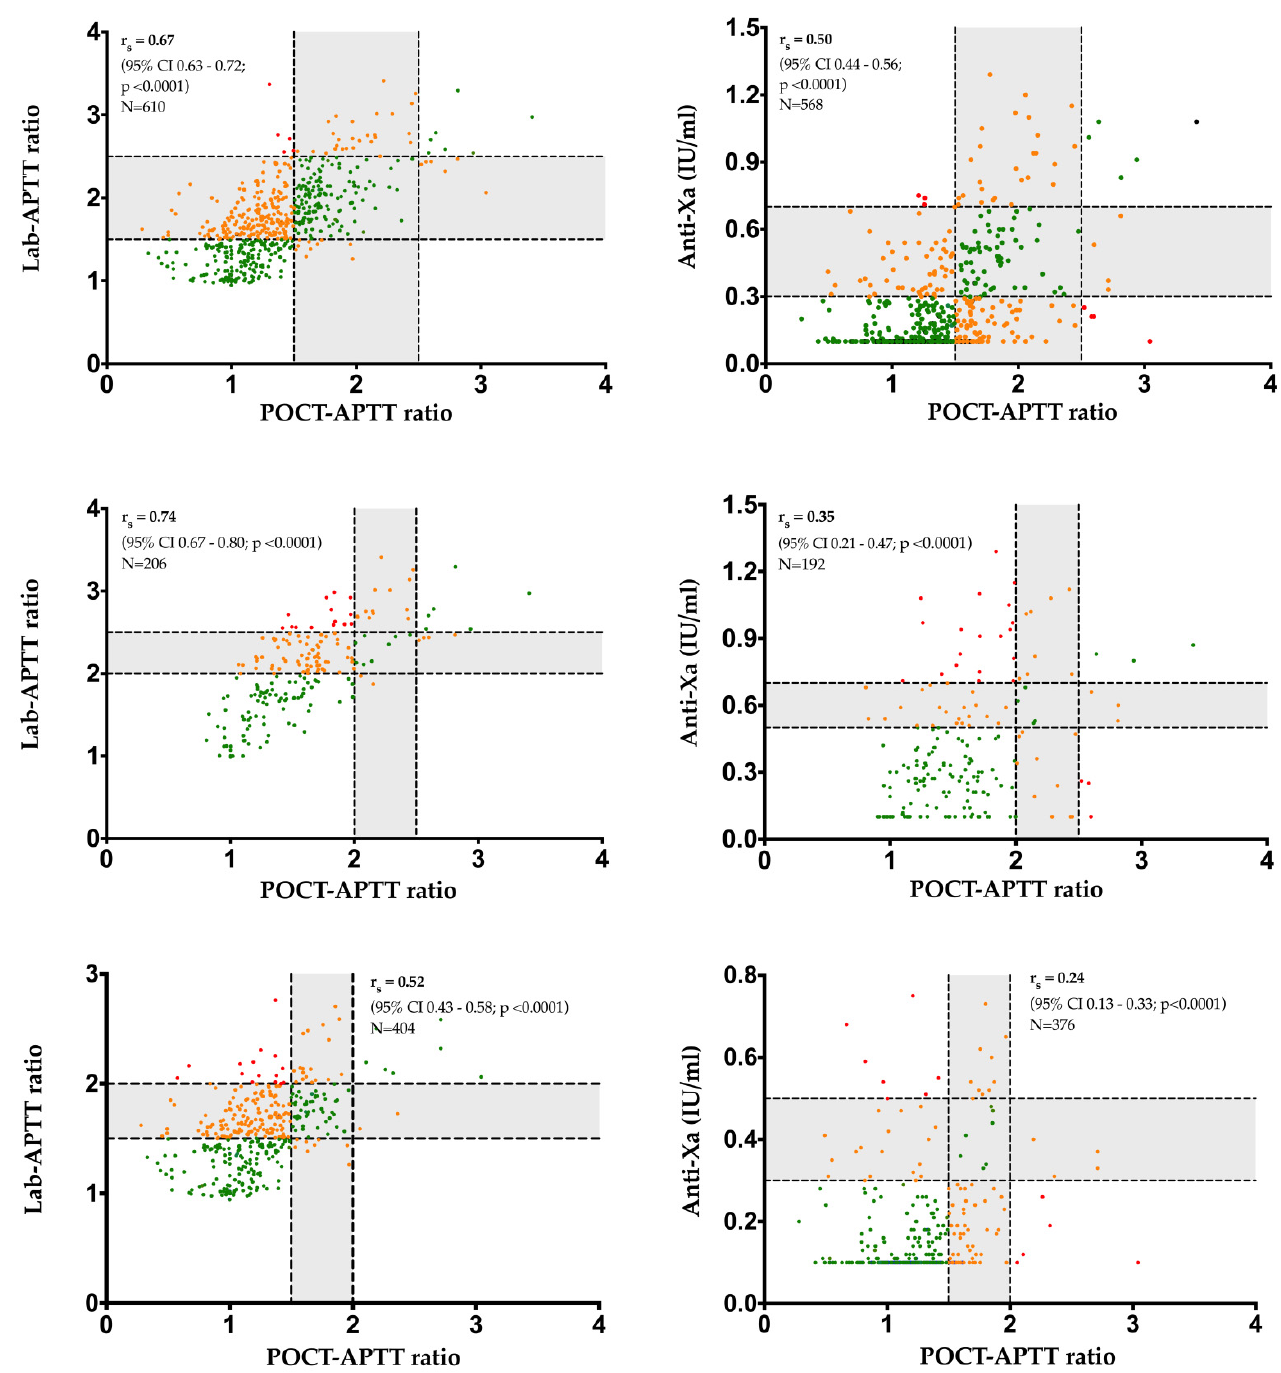
Figure 4. Correlations of the POCT-APTT ratios vs. laboratory APTT ratios (left panels) and POCT- APTT ratios vs. chromogenic anti-Xa activity measurement (right panels), according to overall (top panels), high (center panels) or low (bottom panels) therapeutic target ranges from the 29 patients with basal POCT and basal lab-APTT measurements. The grey zone corresponds to the desired therapeutic range and tick lines represent the lower and the upper limits of this range for the corresponding assay. Pairs in agreement, unsatisfactory and contradictory categories are symbolized by green, orange and red dots, respectively. APTT, activated partial thromboplastin time; POCT, point-of-care testing; rs, Spearman correlation coefficient.